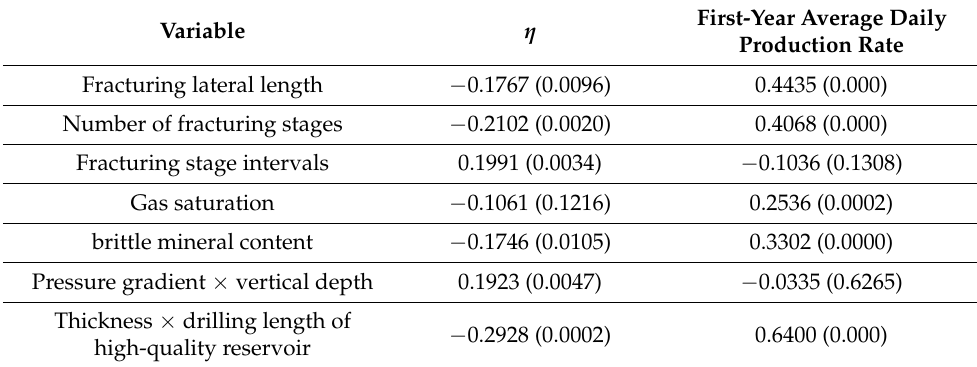
Table 3. Correlations between η , first-year average daily production rate, and static